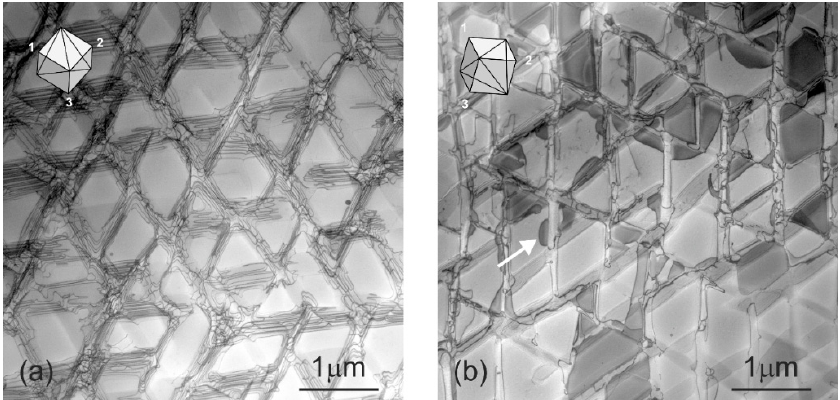
Figure 4. Scanning transmission electron microscopy (STEM) micrographs showing dislocation microstructures, which formed during shear creep deformation at 750 °C and 300 MPa to 1% strain. ( a ) Macroscopic shear system [ 011 ]( 111 ) . ( b ) Macroscopic shear system [ 112 ]( 111 )